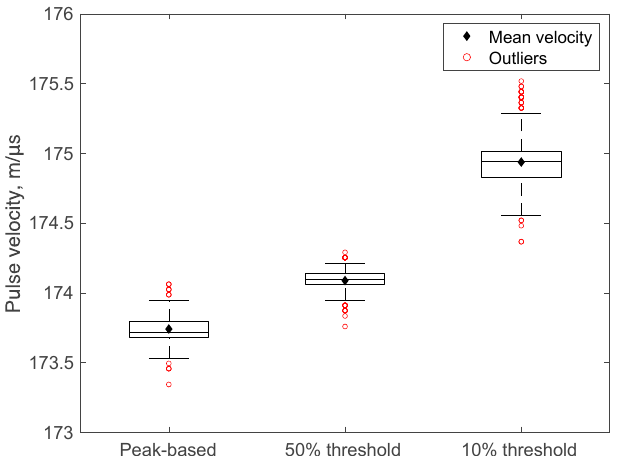
Figure 4. Pulse velocity box plots for 1 nC pulse injected near the cable’s end, measured using HFCT.